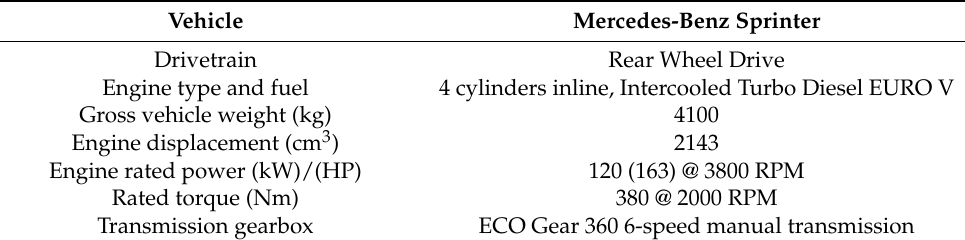
Figure 1. Region of study. Source: Google Maps. Figure 2. CircuitoTec shuttle service routes. Table 1. Shuttle service vehicle specifications.